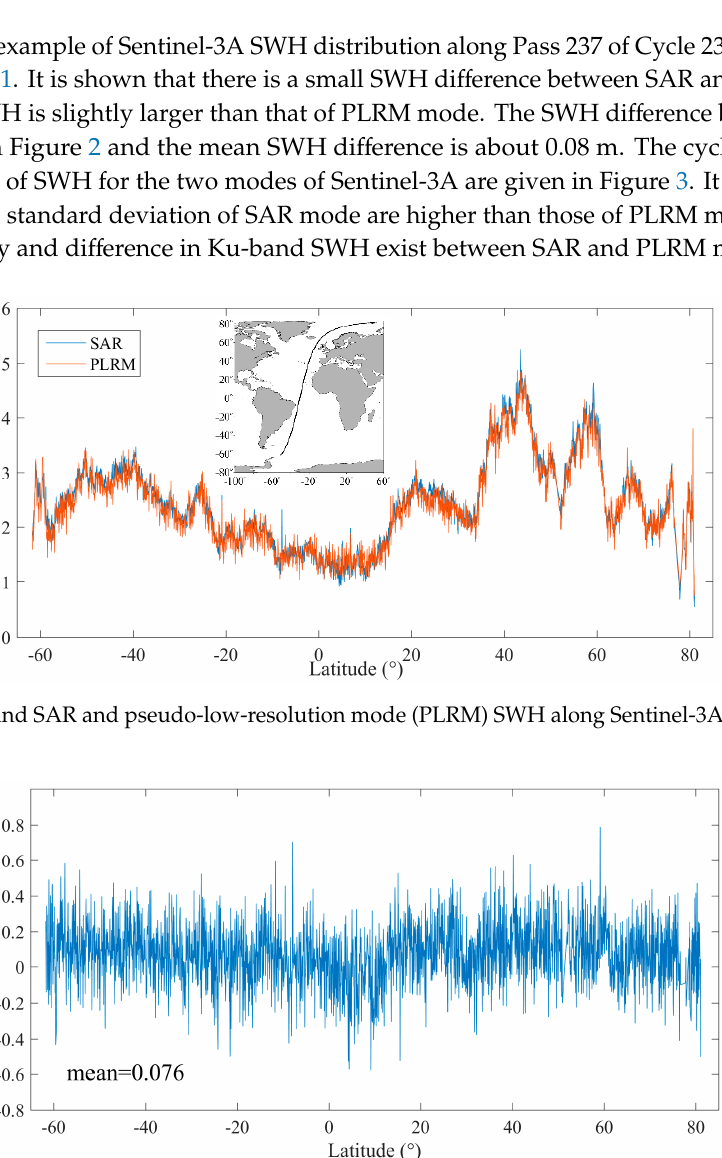
Figure 2. SWH difference between SAR and PLRM modes along Sentinel-3A SRAL Cycle 23 pass 237.